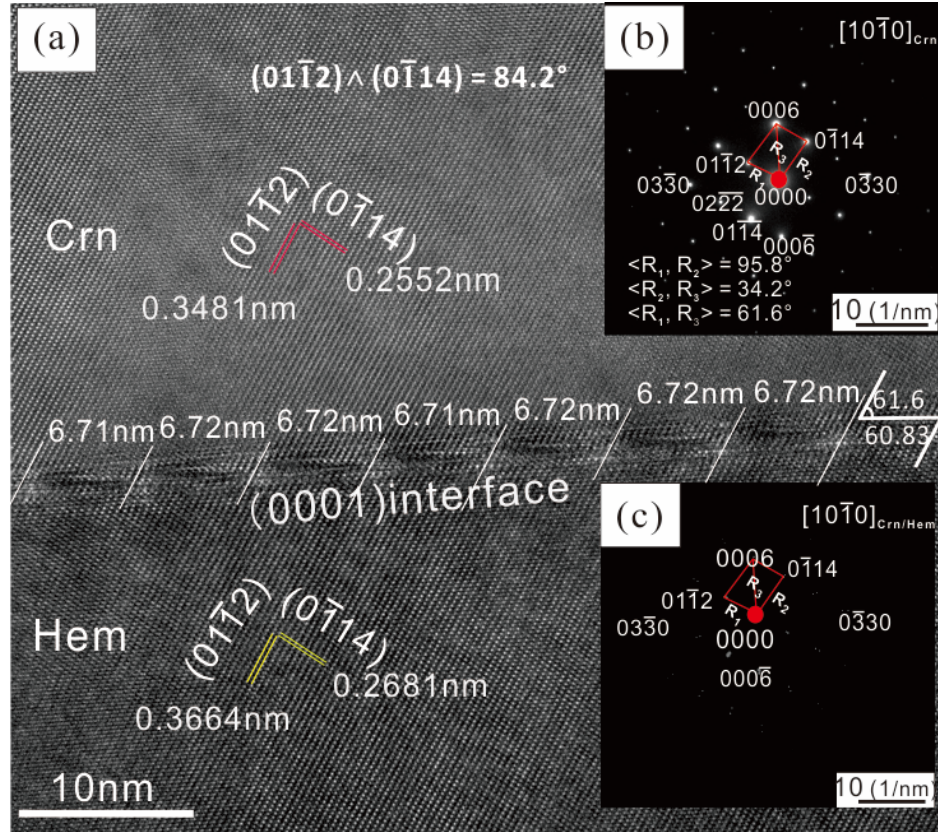
Figure 7. High resolution photograph and SAED patterns of the exsolutions and the host.( a ) HRTEM photograph of the hematite-corundum interface domain, the lattice distances (d Crn and d Hem ) of the two phases are measured in the photograph. The angel between (0112) and (0114) is 84.2°. The period lengths of 6.71–6.72 nm are marked on the photograph, respectively. ( b ) SAED patterns of the corundum host in reciprocal space. The angle between <R 1 , R 2 > = 95.8°, <R 2 , R 3 > = 34.2°, <R 1 , R 3 > = 61.6°. The indexation of corundum is labeled. ( c ) SAED patterns of the interface. The patterns are split into two sets, they represent the corundum and hematite, respectively. The indexation of hematite is labeled. The zone axes are [1010] for both corundum and